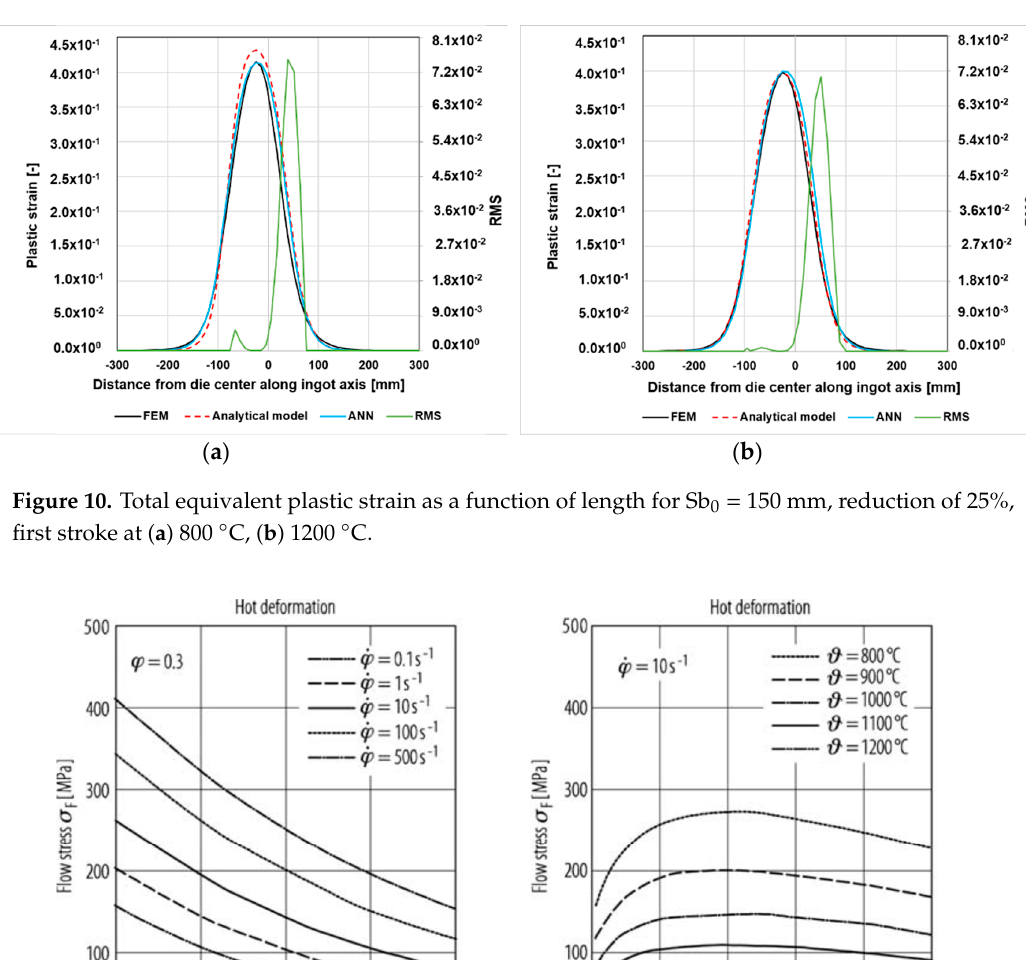
Figure 9. Total equivalent plastic strain as a function of length for Sb 0 = 150mm, reduction of 5%, first stroke at ( a ) 800 °C, ( b ) 1200 °C.